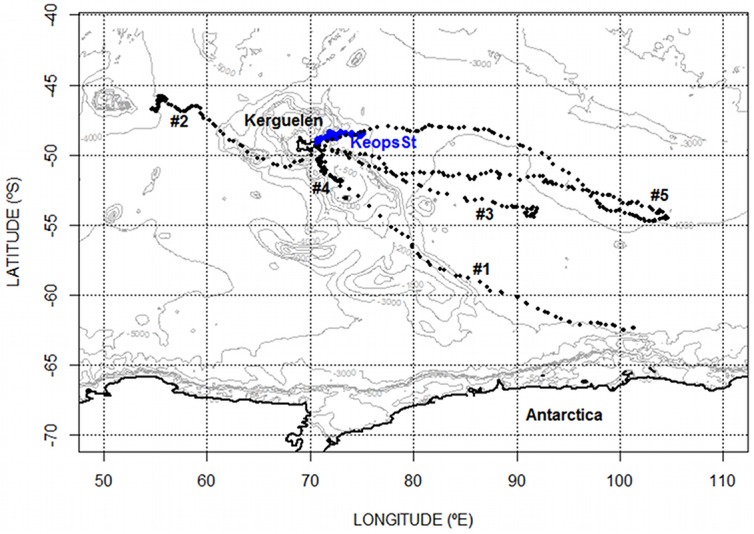
Location of oxygen profiles recorded by Kerguelen elephant seals and the ship survey Keops2.The seal profiles were obtained during the post-breeding foraging trip of 5 females. The individual #1 was equipped in October 2010. The 4 other females (#2 to #5) were equipped in October 2011. Blue dots correspond to the Keops2 stations (Keops St). The Keops survey was conducted in October and November 2011. Isobaths are illustrated in light gray.